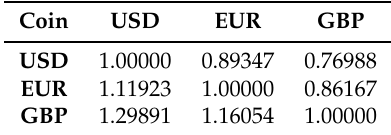
Table 2. Cross exchange rates. Source: